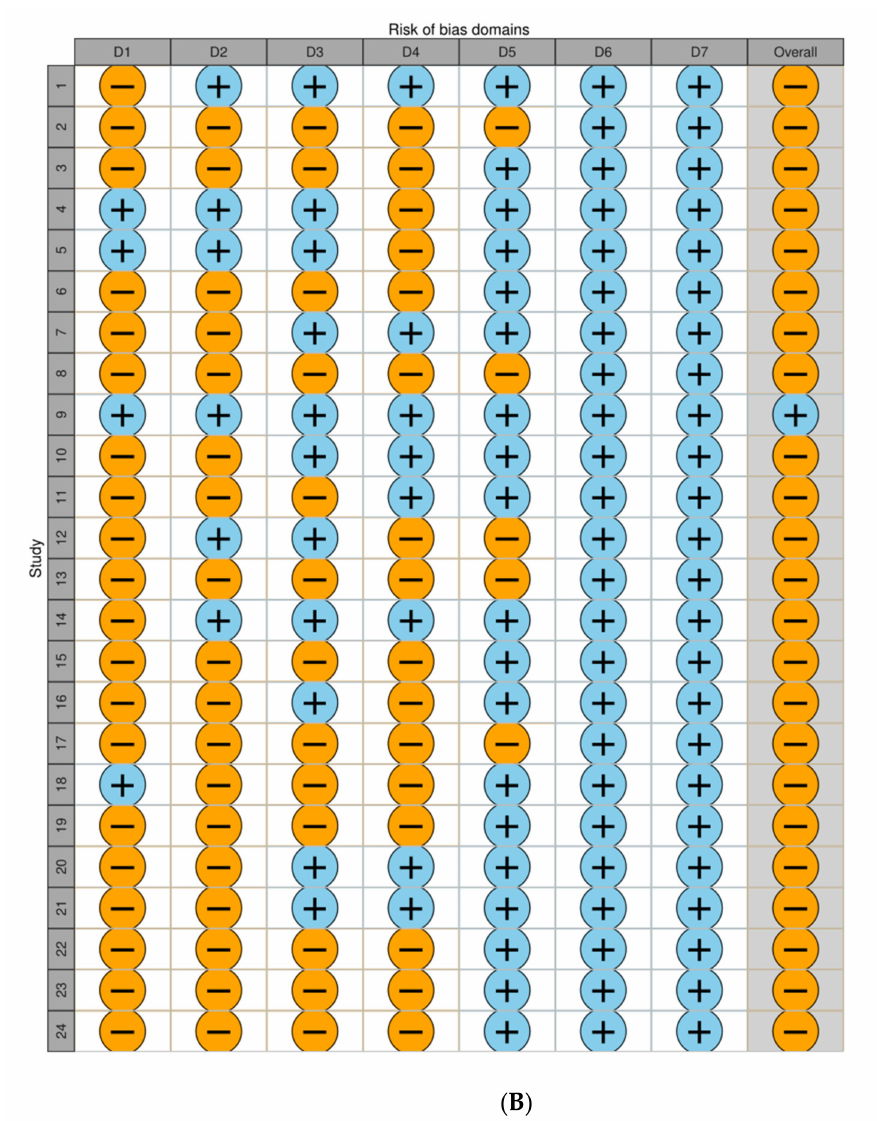
Figure 2. Risks of bias for the included studies. ( A ): Risk of bias graph; ( B ): risk of bias sum- mary. D1 = Random sequence generation (selection bias), D2 = Allocation concealment (selection bias), D3 = Blinding of participants and personnel (performance bias), D4 = Blinding of outcome assessment (detection bias), D5 = Incomplete outcome data (attrition bias), D6 = Selective reporting (reporting bias), D7 = other bias. Sky blue (+) = low risk of bias, Orange ( − ) = unclear risk of bias, Turquoise ( × ) = high risk of